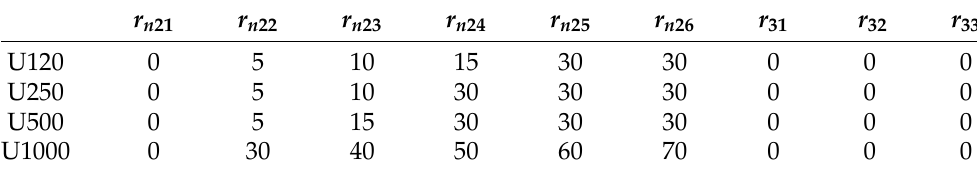
Table 5. Parameter setting for the Falkenauer U class in lines